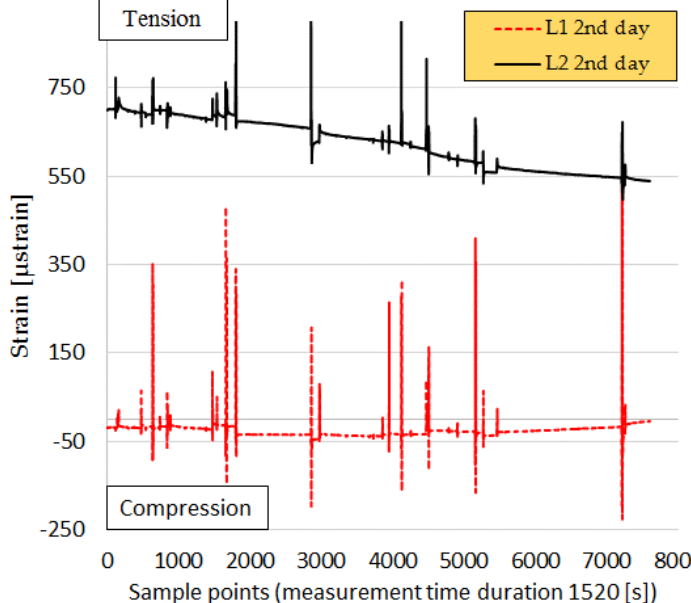
Figure 12. Strain values of sensors L1 and L2 during the construction of the CyPaTs asphalt pavement on the second day.